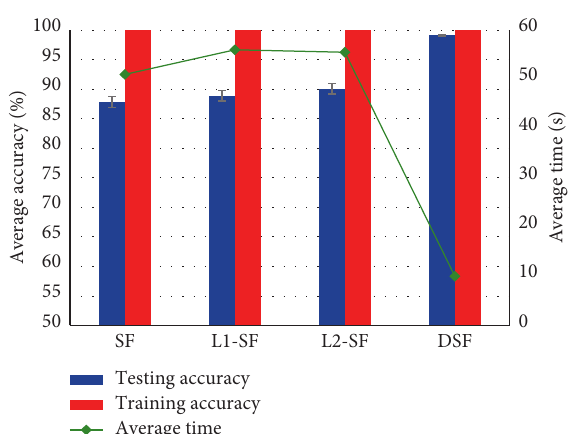
Figure 11: Comparison of the average diagnostic accuracies of four SF models.